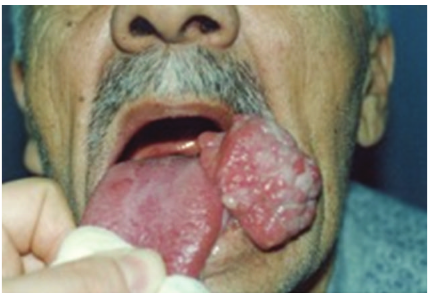
Figure 1: The mass on the left side of the tongue.